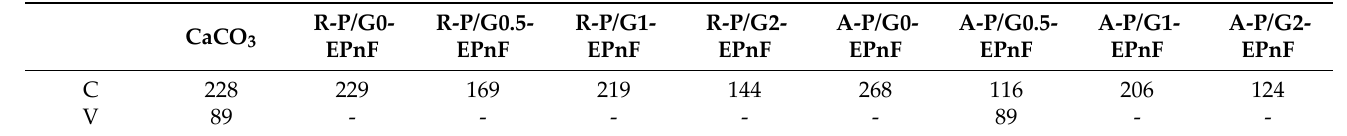
Table 3. Crystallite sizes of calcite (C) and vaterite (V) obtained in GD crystallization assays on the